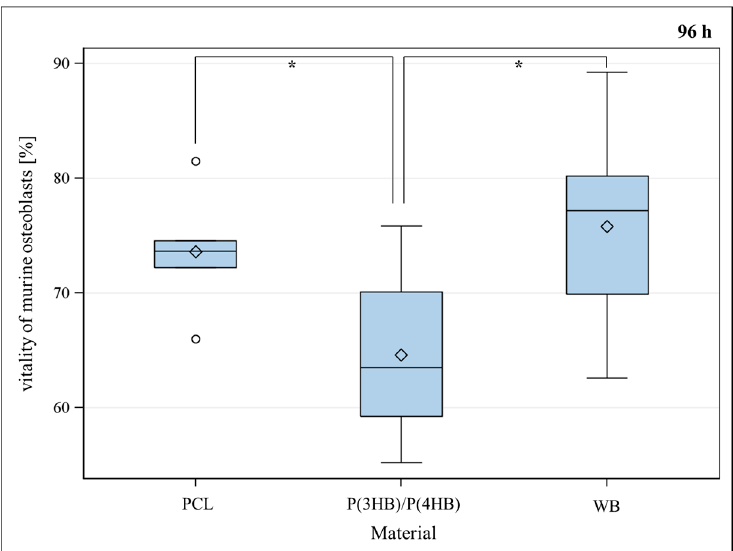
Figure 1. Vitality (%) of murine osteoblasts settled on PCL (poly- ε -caprolactone), P(3HB)/P(4HB) (poly(3-hydroxy-butyrate)/poly(4-hydroxy-butyrate)) and WB (well bottom) for 96 h. Global F -test from the analyses of variance followed by pairwise multiple means comparisons with the Least Significant Difference test showed a significant difference between PCL and (P(3HB)/P(4HB)) meanwhile between WB and (P(3HB)/P(4HB)) (* = p ≤ 0.05, n = 8; circle = outlier; rhombus = mean; centered line = median).